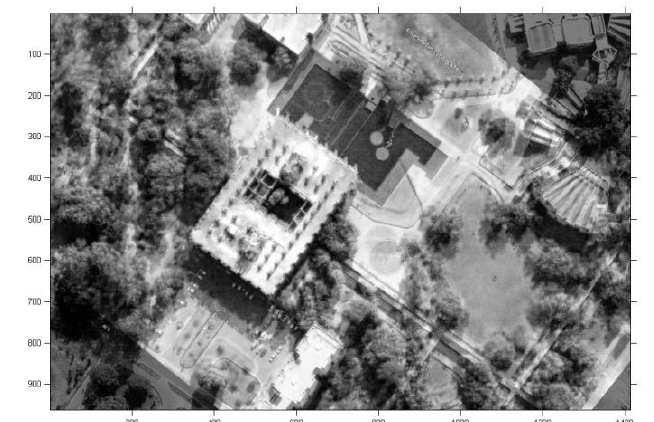
Figure 8. Automatic Image registration of Google Earth and Aerial Image using SURF of Library Building in IIT